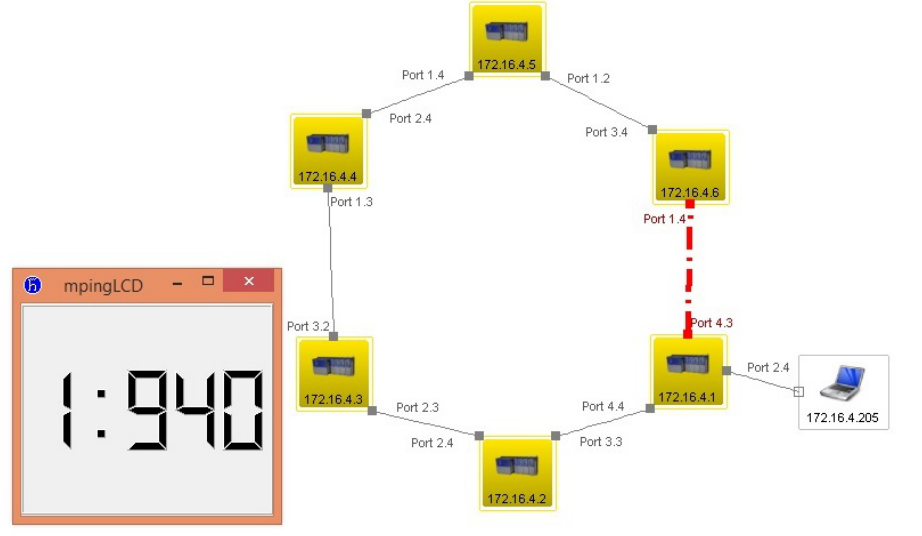
Figure 17. RSTP ring network with one cable (link)